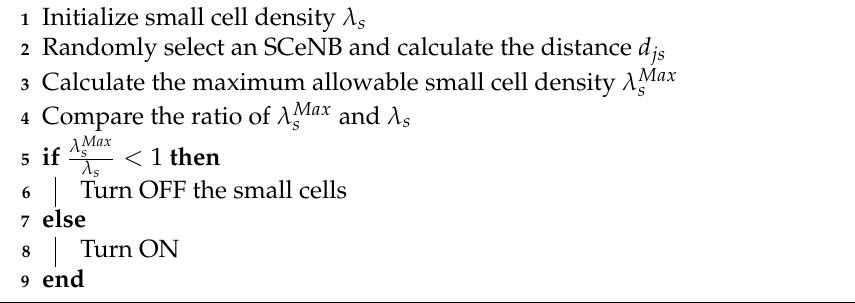
Algorithm 2: ON-OFF algorithm for interference